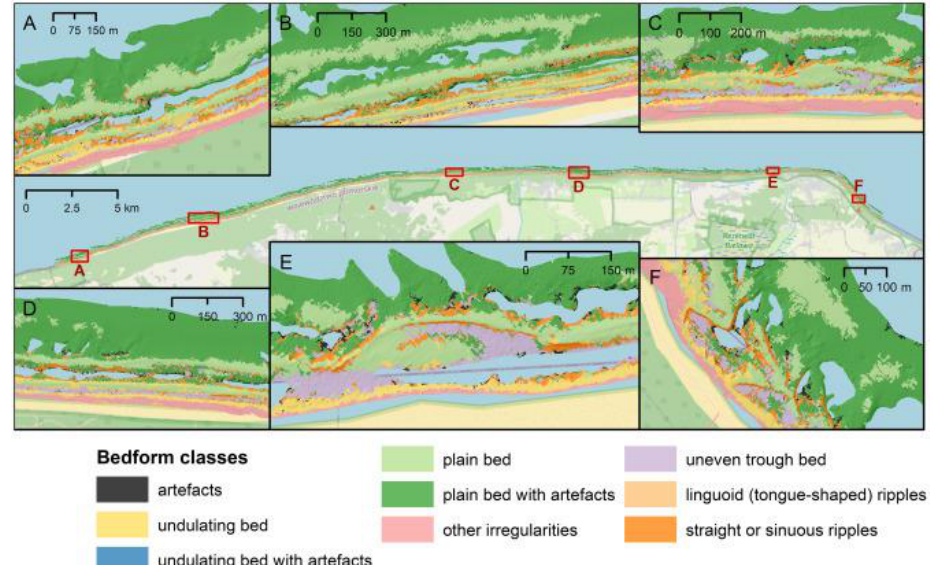
Figure 11. Classes of geomorphological bedforms automatically mapped using ALB and machine learning supervised, ( A – F ) subsets of the study site marked on the general map